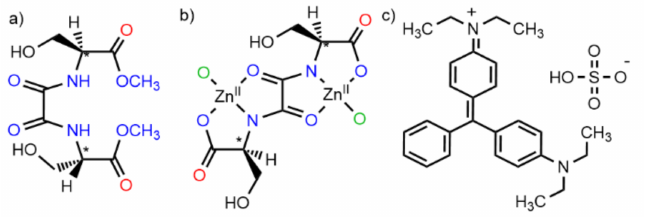
Figure 1. Chemical formulas of the proligand ( S , S )-serimox ( a ) and the secondary building units (SBU) consisting of Zn II dinuclear units ( b ). Red oxygen atoms coordinate Zn II atoms from another SBU, whereas green oxygen atoms belong to neighboring SBUs. ( c ) Chemical formula of brilliant green dye.